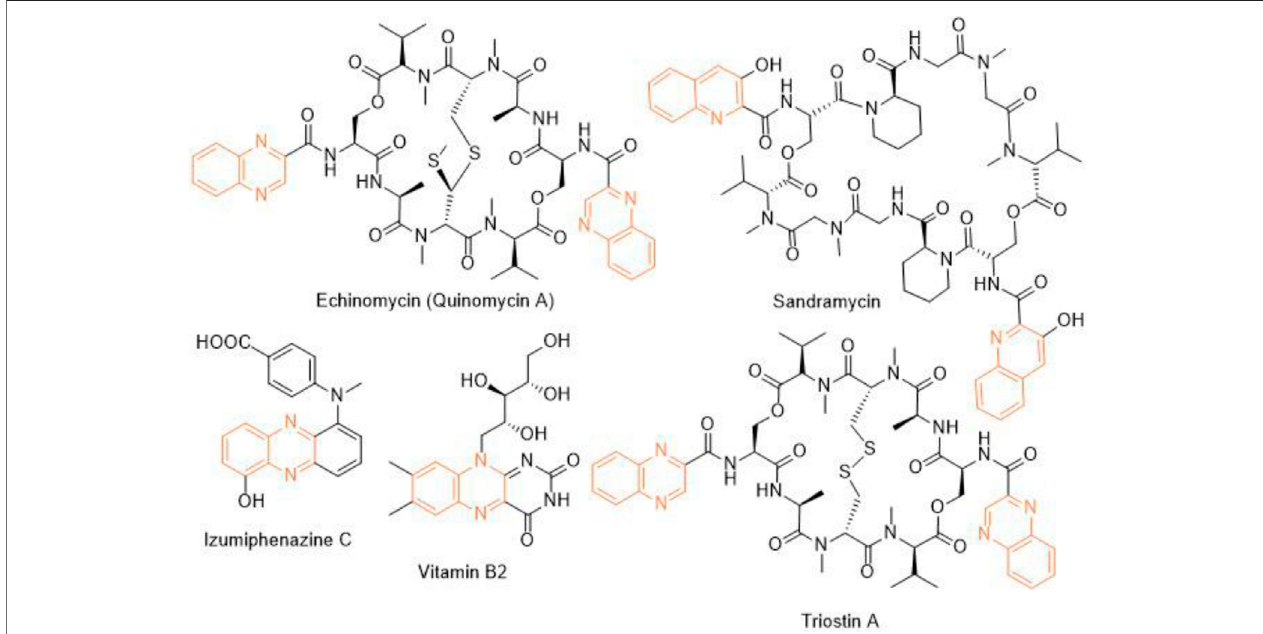
FIGURE 1 | Representative examples of naturally occurring bioactive benzopyrazines.